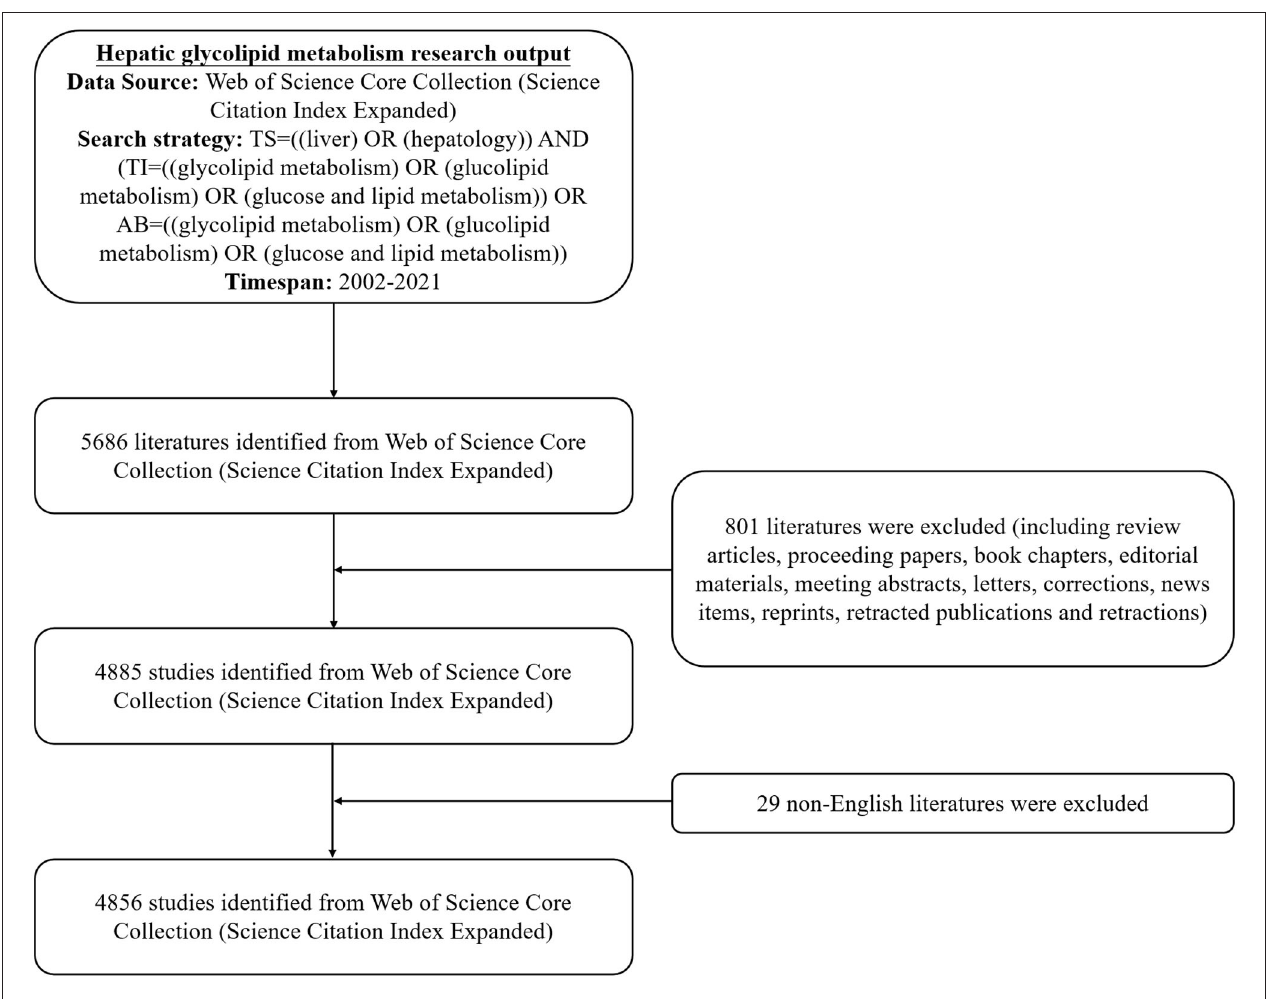
FIGURE 1 | A flowchart for including and excluding